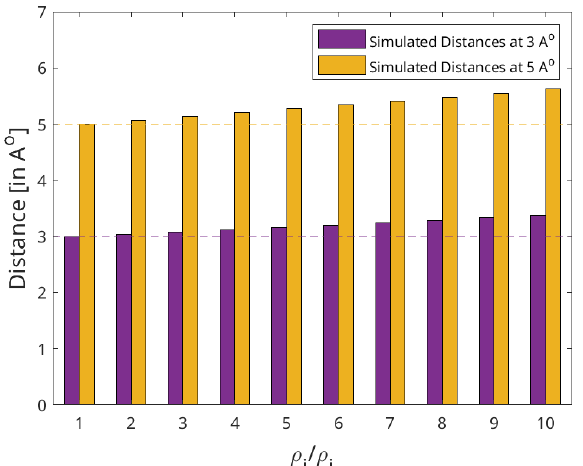
Figure A2. The effect of the relative auto-relaxation rates of the protein and the ligand on the distances extracted via the diagonal-normalised approach. The dotted lines represent the artificial distances 3 and 5Å in purple and yellow respectively. The corresponding bars denote the distances back-calculated using the diagonal-normalised approach from the artificial distances depending on the relative auto-relaxation rates, ρ i and ρ j . Each set of distances (bars) are derived through varying assumptions of the values of ρ i and ρ j with respect to each other ρ j = [1 to 10]. ranging from ρ i